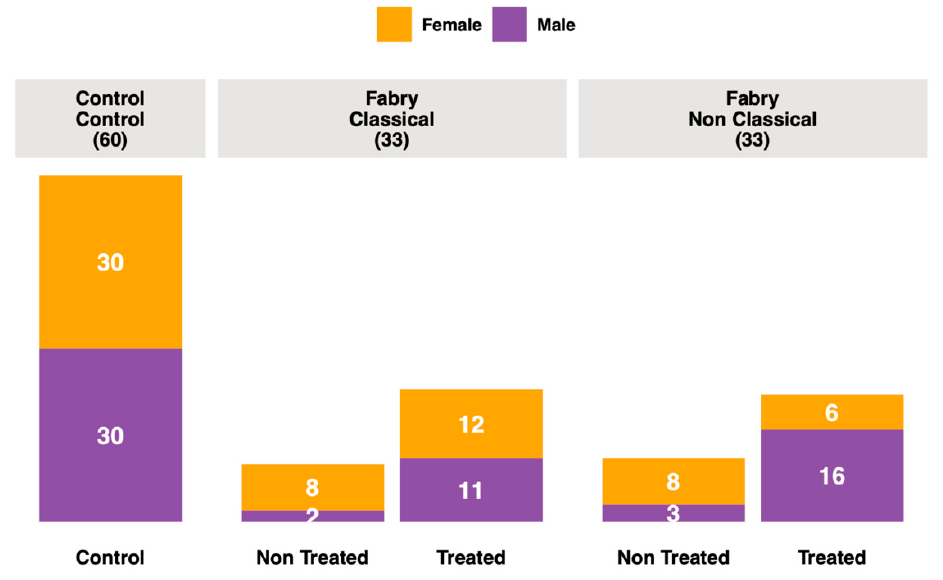
Figure 1. Cohort Figure 1. Cohort description.